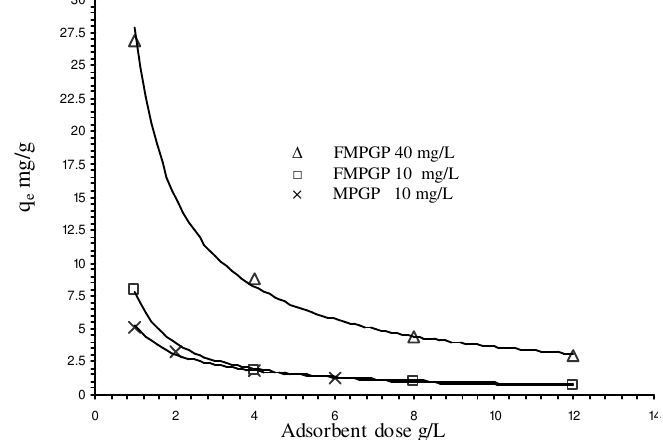
Figure 3 . Effect of contact time on the amount of Cr(VI) adsorbed at equilibrium, q MPGP, 0.1 g/ 50 mL, at pH 2 , temp. 20 0 C and FMPGP, 0.1 g/50 mL, at pH 3 temp. 16 0 C.